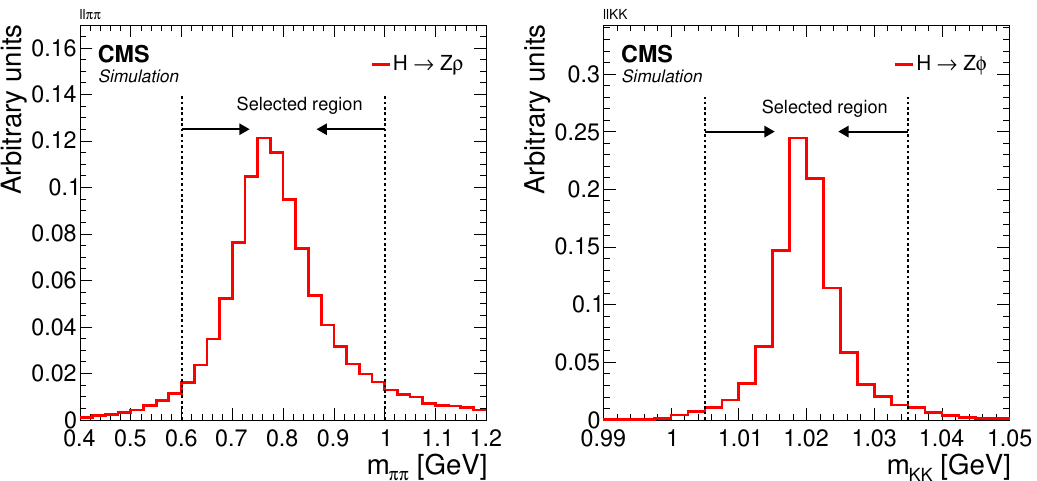
Figure 5 . Distribution of the ditrack invariant mass in simulated H → Z (cid:26) events passing the ‘‘ (cid:25)(cid:25) selection criteria (left) and in simulated H → Z (cid:30) events passing the ‘‘ KK selection criteria (right). These masses are calculated assuming the charged particle mass equals the pion mass in the ‘‘ (cid:25)(cid:25) selection and assuming the charged particle mass equals the kaon mass in the ‘‘ KK selection. The events pass all selection criteria described in the text, apart from the requirements on the ditrack invariant mass window. The dashed lines indicate the region selected in the